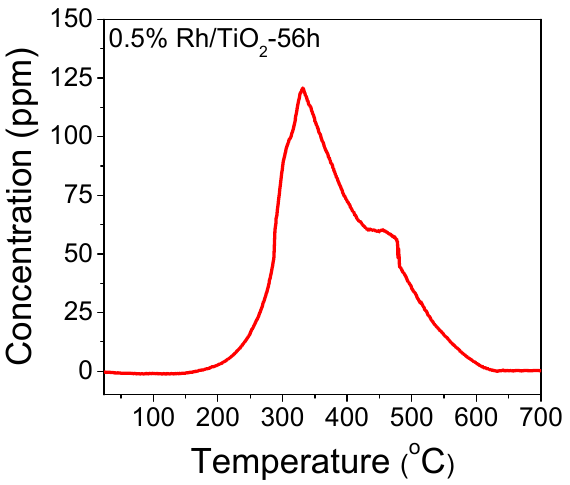
Figure 11. Responses of CO 2 produced during temperature-programmed oxidation with 3% O 2 (in He) occurred after the stability test of Figure 10 conducted over Rh/TiO 2 catalyst.